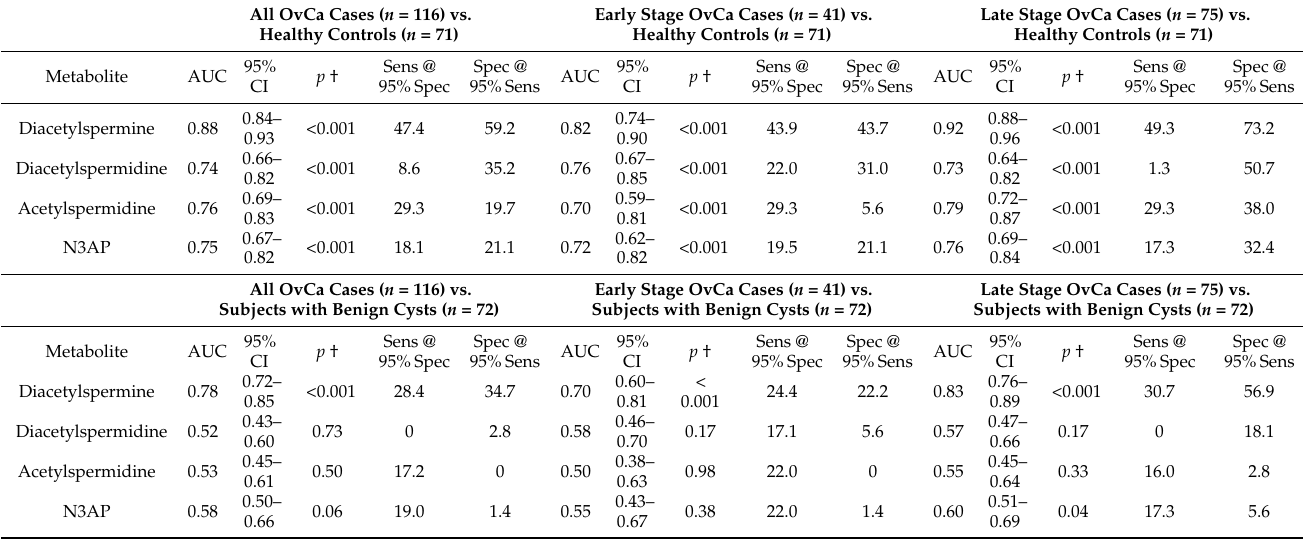
Early Stage OvCa Cases ( n = 41) vs. Healthy Controls ( n = 71)